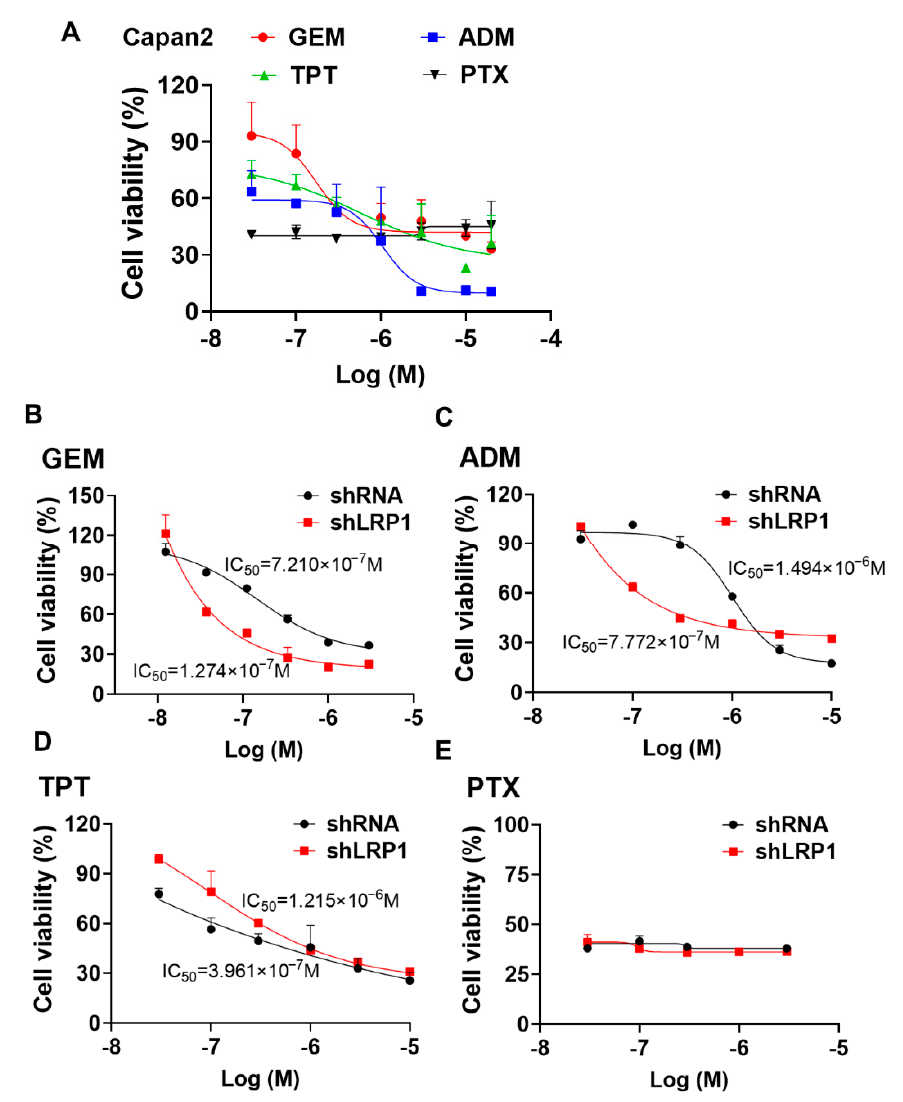
Figure 6. Silencing LRP1 could enhance chemo ‐ sensitivity in PC cells. ( A ) The cell viability of Capan-2 was determined by MTT assay after exposure to different chemotherapeutic drugs for 72 h. The data are expressed as the mean ± SD of the results from three separate experiments. ( B – E ) The Capan-2 cells stably transfected control shRNA and targeted shLRP1 were administrated different concentrations of gemcitabine (GEM), doxorubicin (ADM), topotecan (TPT) or paclitaxel (PTX) for 72 h; the cell viability was detected by MTT assay.